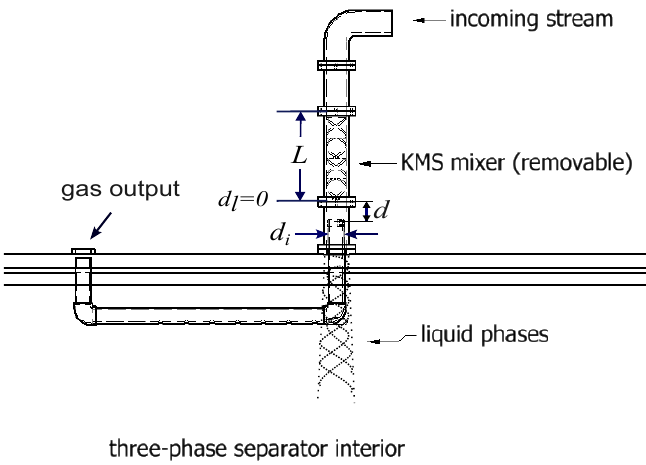
Figure 2. Physical configuration of the KMS as the inlet device with the main parameters to be